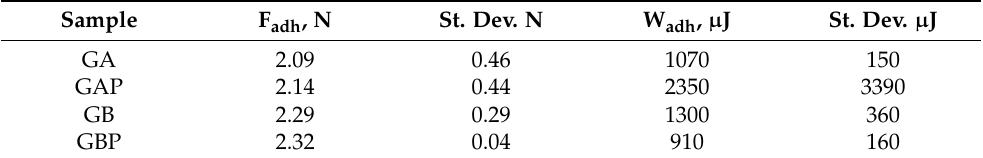
Table 4. Results of the mucoadhesion test, the mucoadhesive force (F adh ), and the work of adhesion (W adh ).